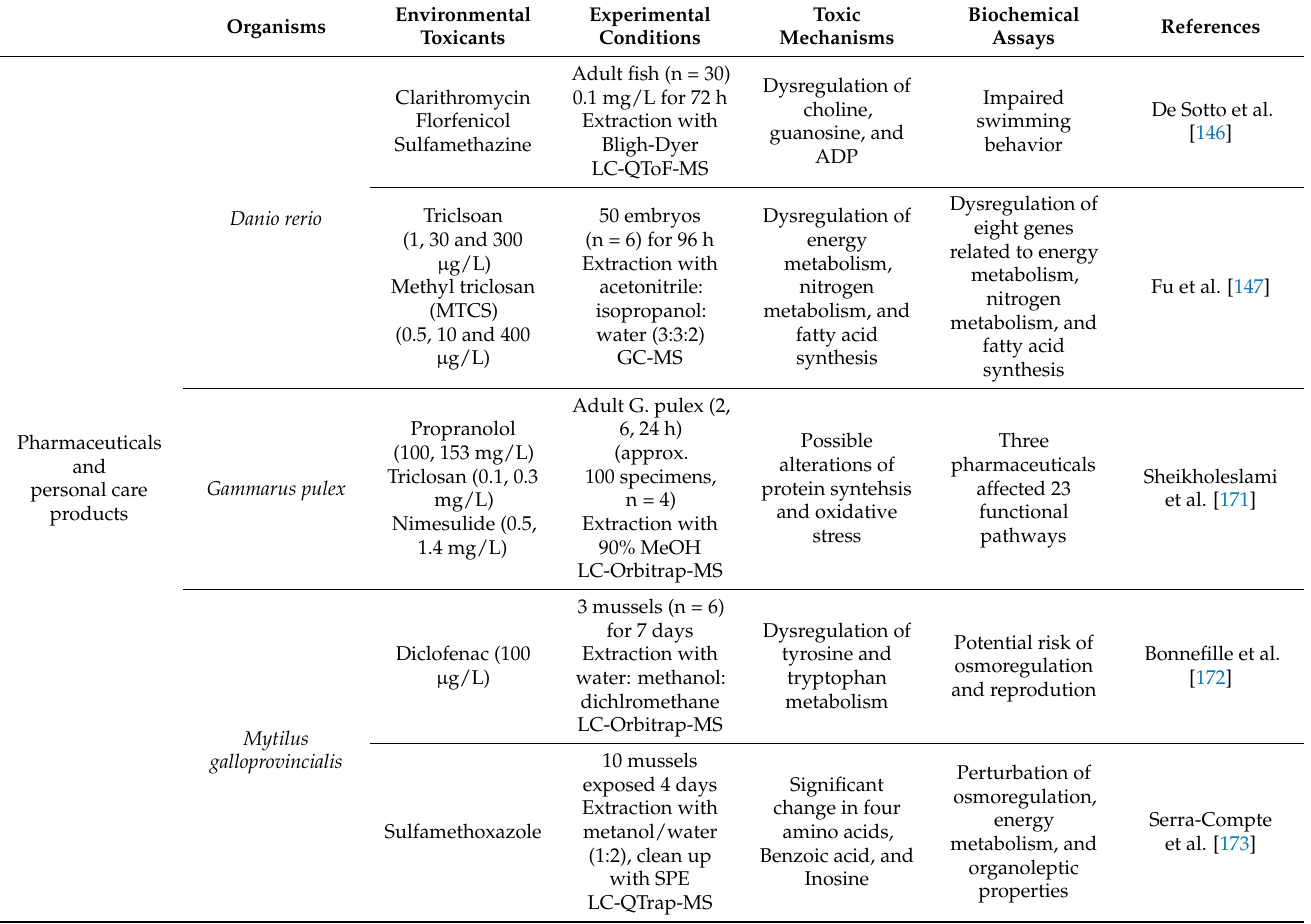
Table 3. Summary of perturbation of metabolic pathways in model organisms in response to environmental toxicants.